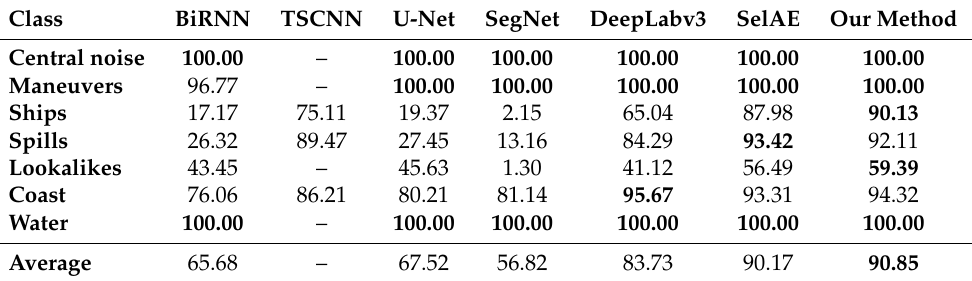
Table 6. Results of the object detection of each class using the Intersection over Union metric (IoU %). Best results per row are shown in